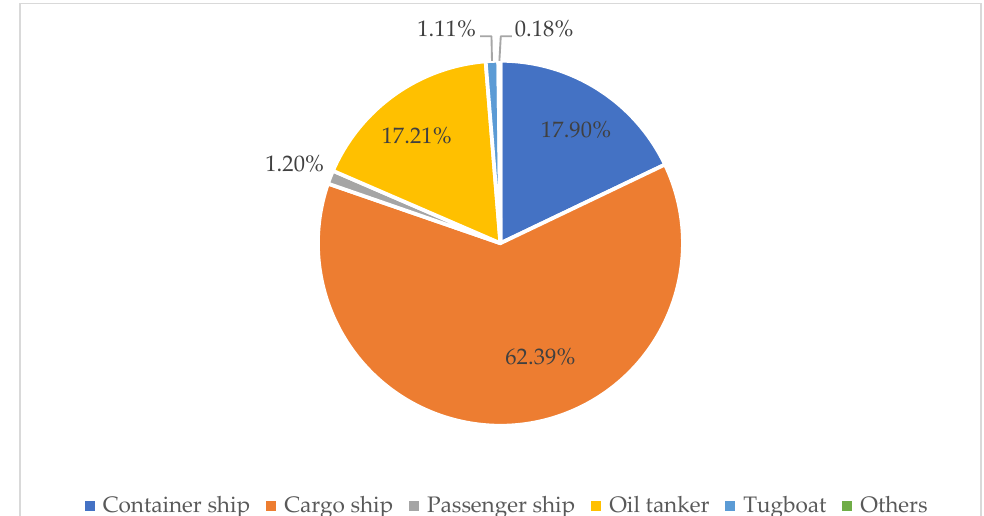
Figure 6. Ship type proportions in the AIS records.